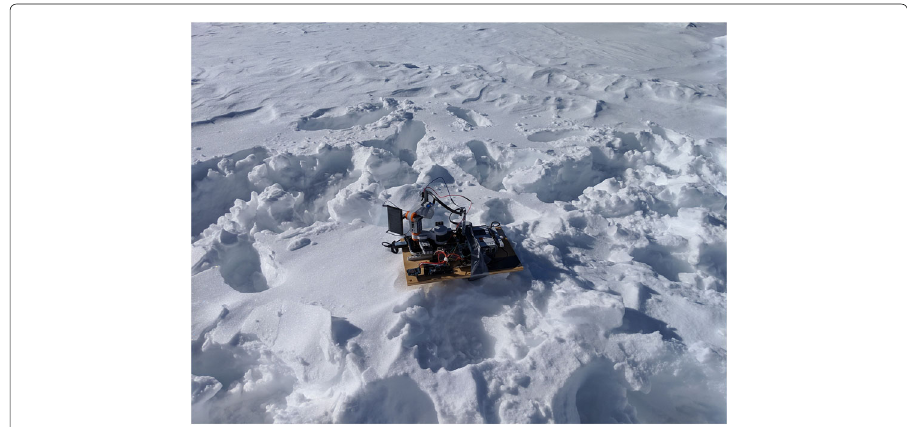
Fig. 3 System deployed at mountain side on snowy ground